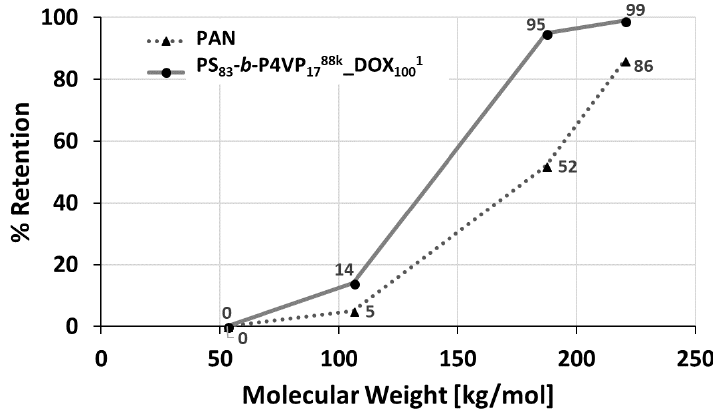
Figure 8. Retention measurement of a PS 83 - b -P4VP 1788k _DOX 1001 (circle) on PAN membrane and the pristine PAN membrane (triangle). Aqueous poly(ethylene glycol) (PEG) solutions of 0.2 wt.% with a MW of 53, 106, 187 and 220 kDa were used. The transmembrane pressure (TMP) was set to 2.1 bar. The concentration was determined by gel permeation chromatography (GPC).